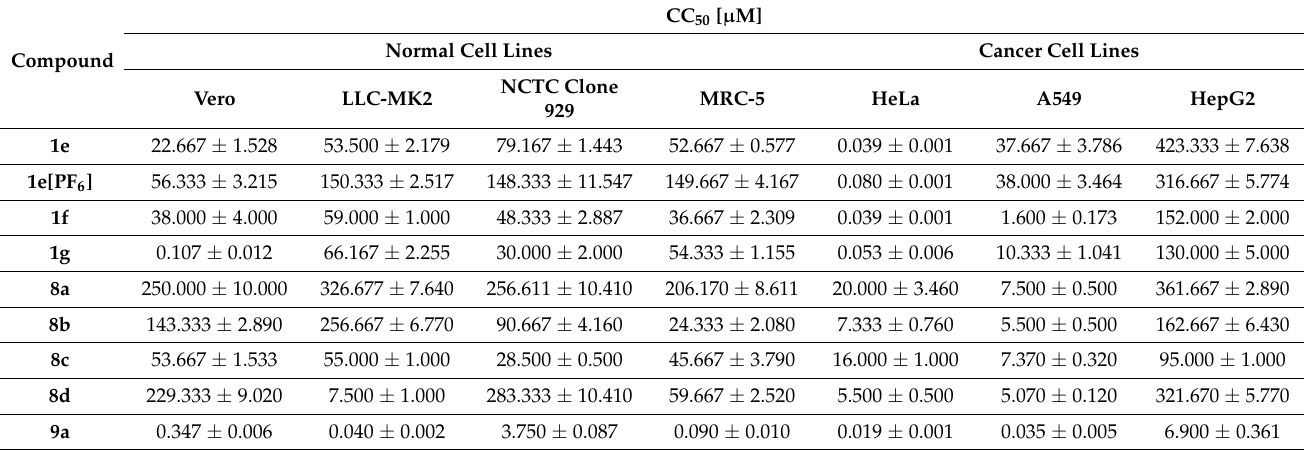
Table 1. Cytotoxic effect of compounds 1e – 1g, 1e[PF 6 ] , 8a – 8d , and 9a on the normal and cancer cell